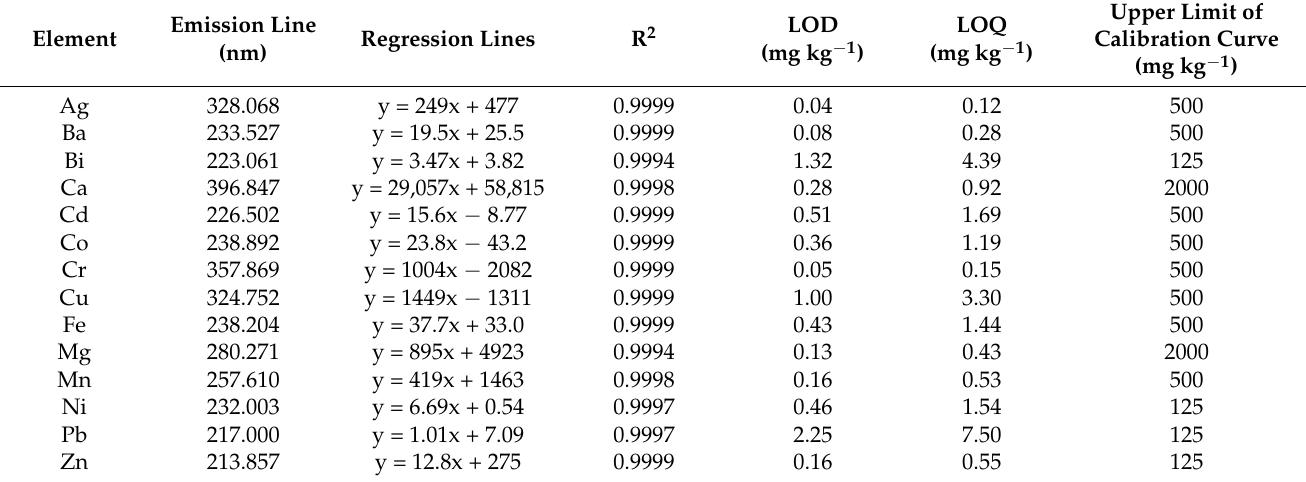
Table 4. Regression analysis, LODs, LOQs and upper limits of the linear range.